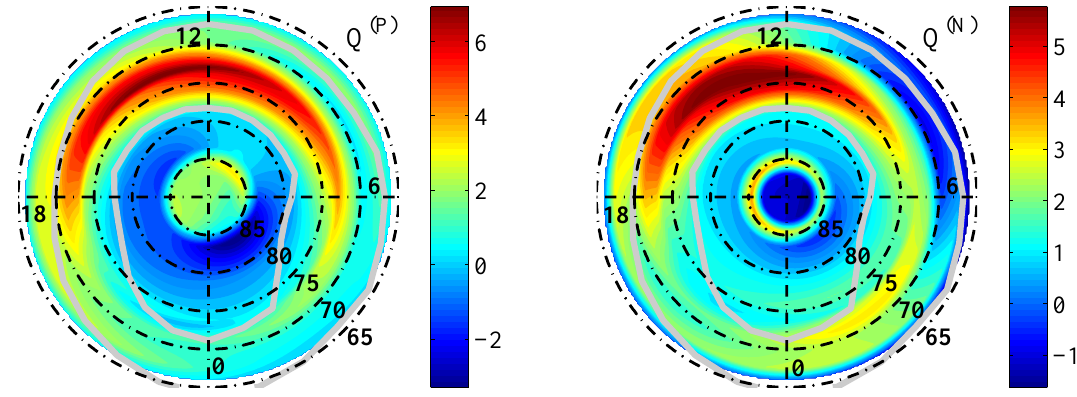
Fig. 9. 2-D distribution of the parameter Q in 8 -MLT coordinates for the P-component (left) and the N-component (right) in the same format as in Fig.